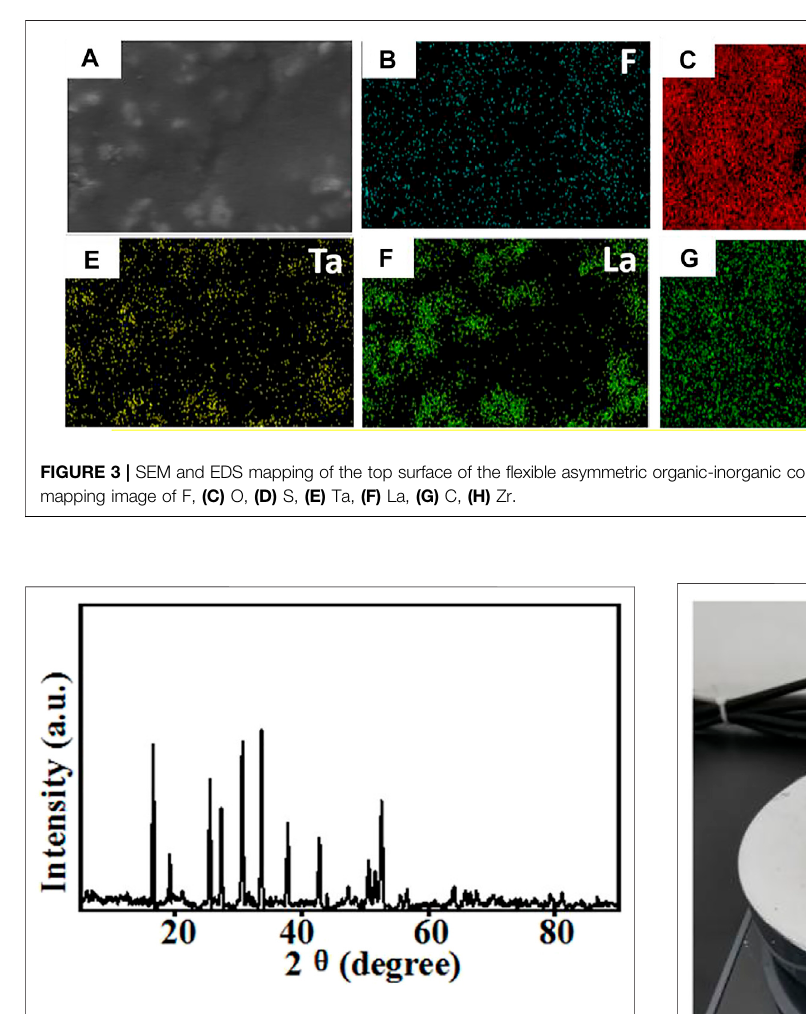
FIGURE 4 | XRD of fl exible asymmetric organic-inorganic composite solid-state electrolyte.